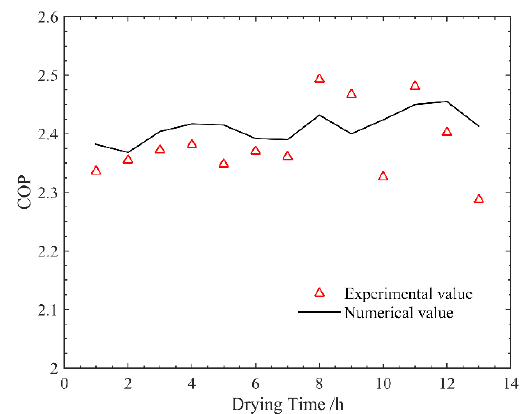
Figure 11. The coefficient of performance (COP) of the system in the course of the drying process.